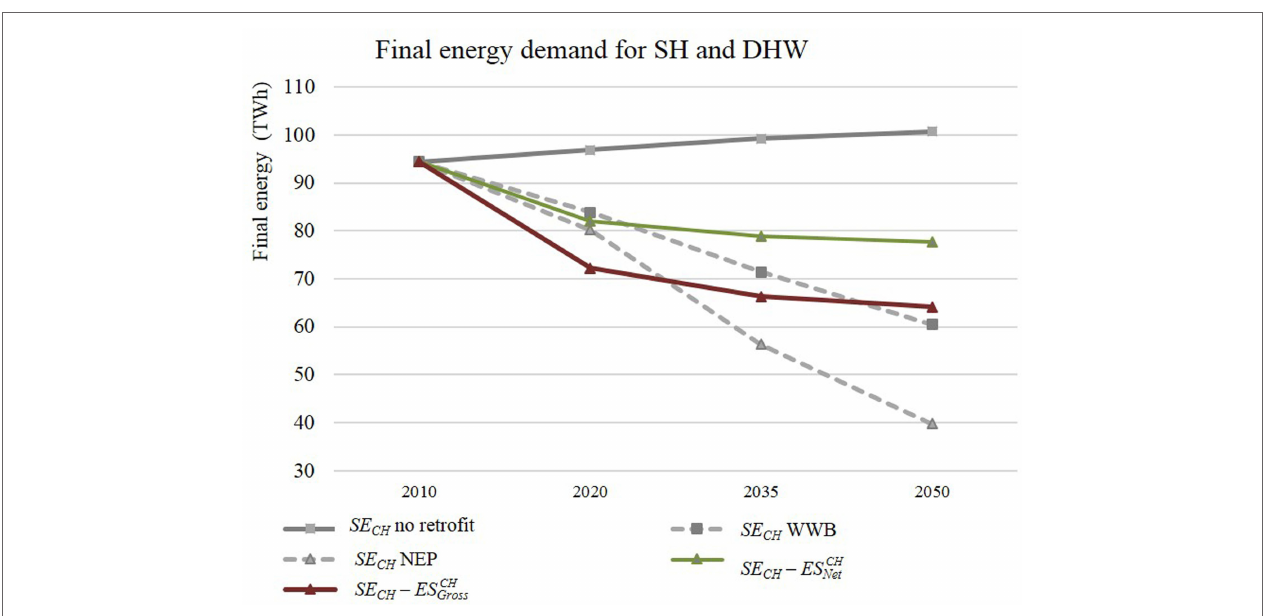
FIGURE 8 | Evolution of final energy demand of the Swiss building stock for SH and domestic hot water